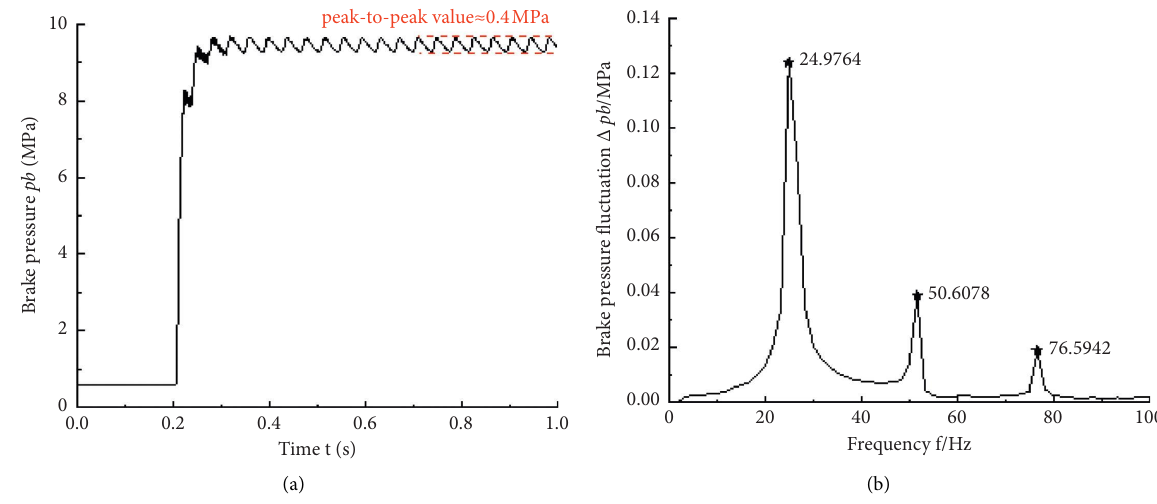
Figure 5: Te brake pressure under step signal. (a) Brake pressure time domain curve. (b) Brake pressure frequency domain